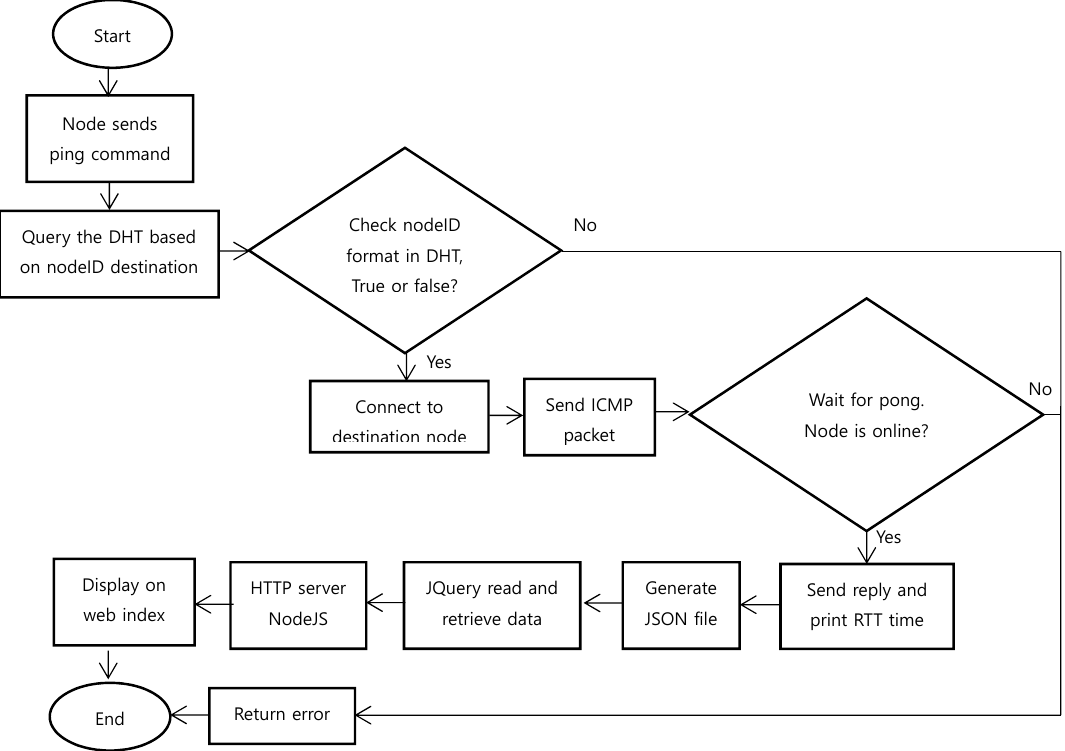
Figure 7. Flowchart of node status monitoring by the active approach.